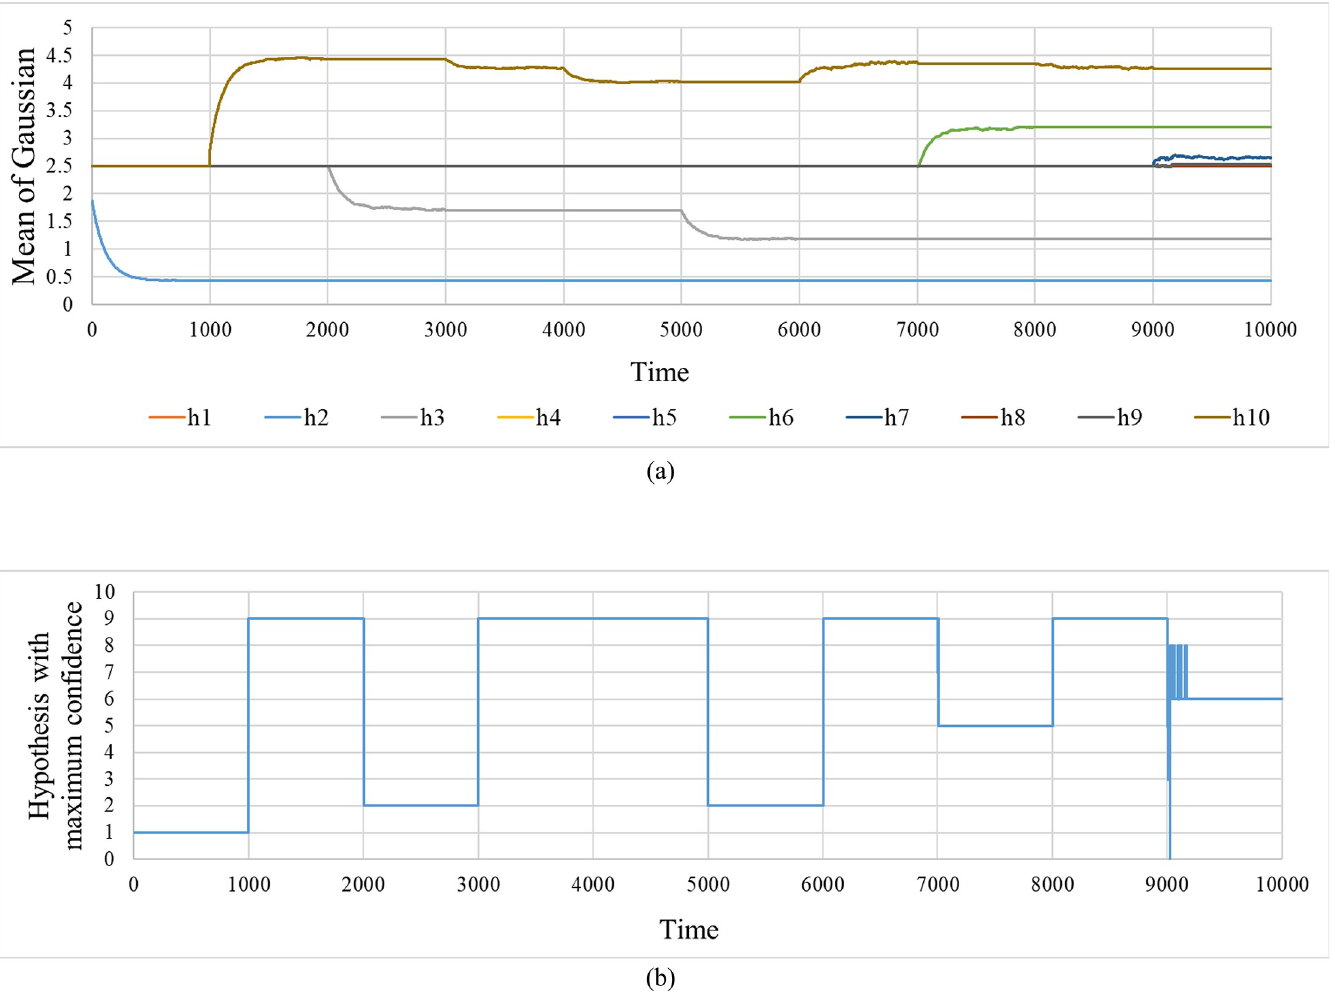
Fig 3. Internal state of extended Bayesian inference. (a) Time progress of the mean of normal distribution for each hypothesis. (b) Time progress of the hypothesis with the greatest degree of confidence.